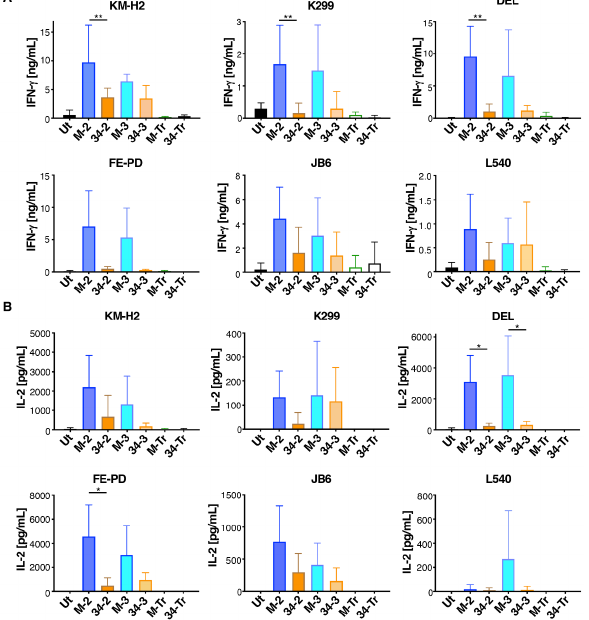
Figure 5. Cytokine production by M-CSFR re-targeted T-cells when co-cultured with lymphoma cell lines. T-cells were engineered to express the specified CARs and then co-incubated at a 1:1 effector:target ratio with the indicated ffLuc/RFP + lymphoma cell lines. Interferon- γ (mean ± SD, n = 3 – 6 independent biological replicates ( A )) and interleukin 2 (mean ± SD, n = 3-4 independent biological replicates ( B )) were measured in supernatants harvested after 24 h. One-way ANOVA was undertaken and selected significant differences are indicated. ** p < 0.01; * p < 0.05.